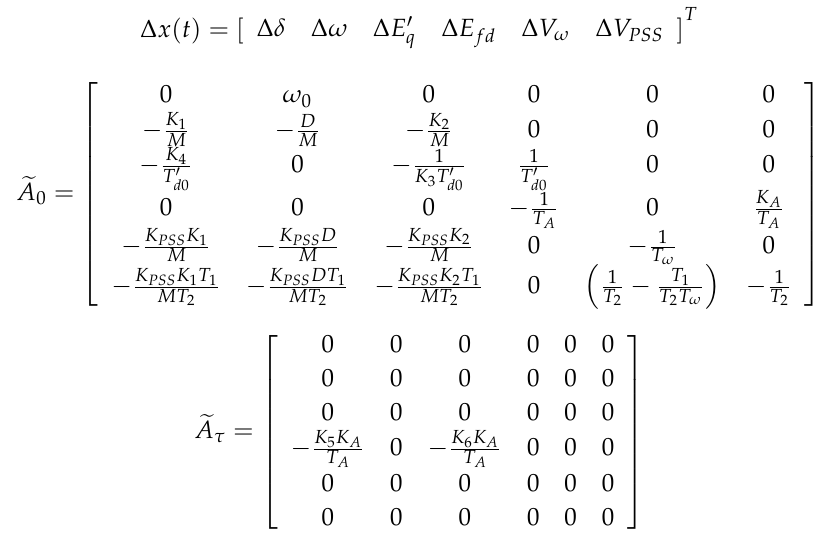
Figure 5. The block diagram of the power system stabilizer.